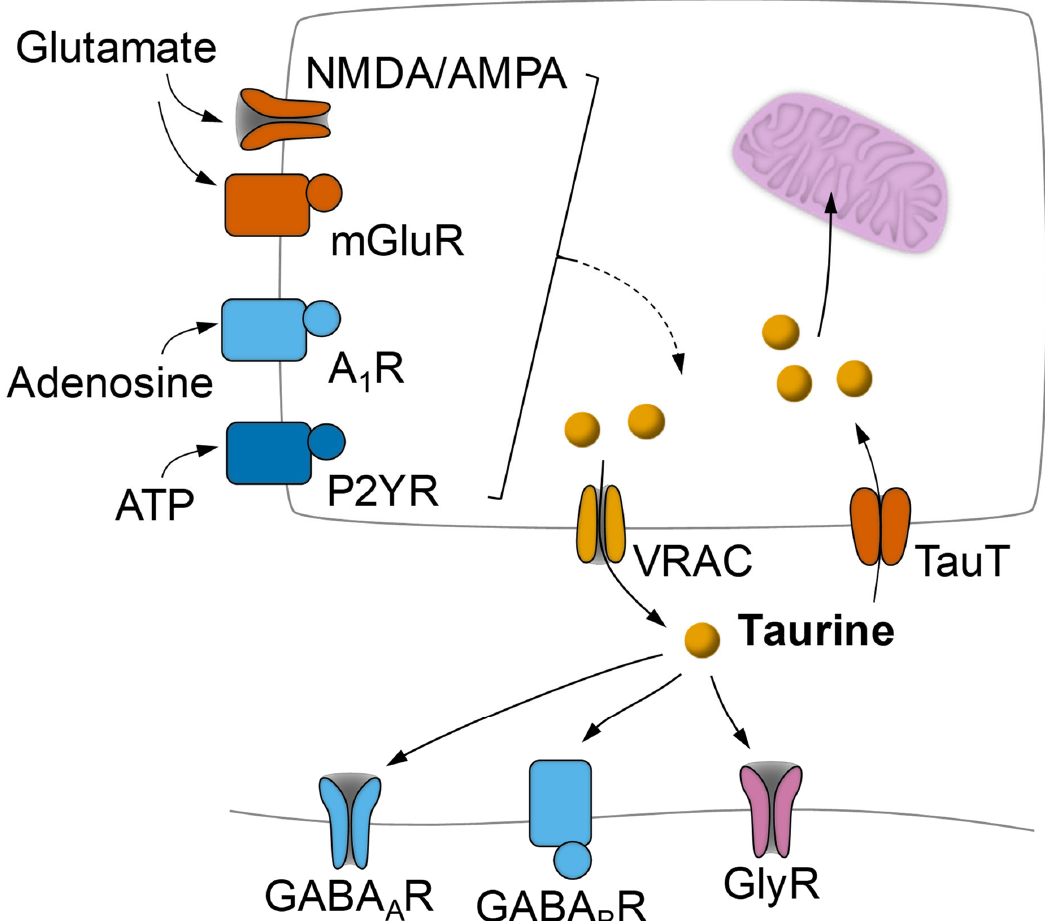
Figure 3. Schematic representation of activity-dependent taurine release modulation from neurons or astrocytes by glutamate and purines and action of taurine on inhibitory receptors. Taurine release is mainly mediated by volume-regulated anion channels (VRAC) that are activated by hypo-osmotic conditions and electrical activity and can be stimulated via glutamate metabotropic (mGluR) and ionotropic receptors (mainly NMDA and AMPA), adenosine A 1 receptors (A 1 R), and metabotropic